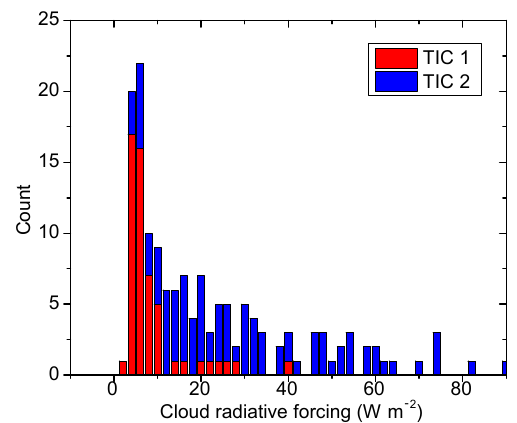
Figure 9. Downwelling longwave cloud radiative forcing of the 150 cases decomposed in TIC1 and